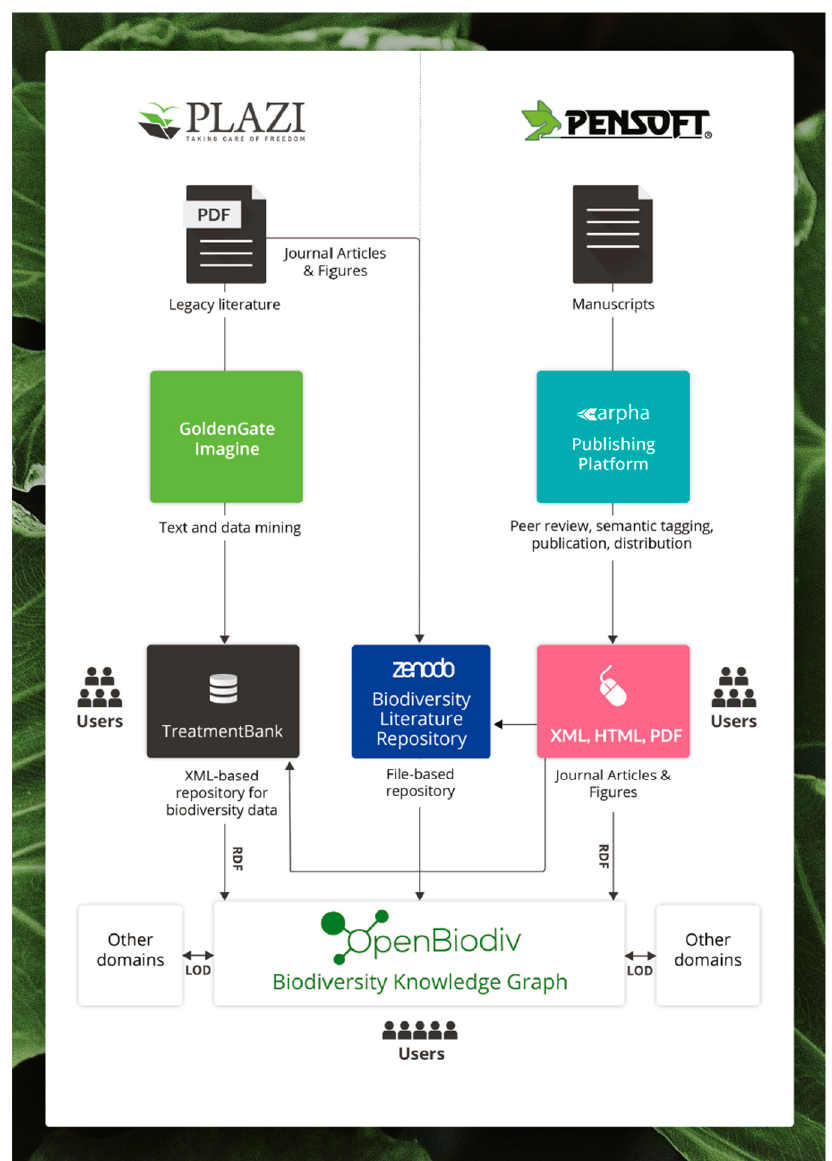
Figure 2. Data extraction and Resource Description Framework (RDF) conversion workflows from prospectively published literature (Pensoft) and legacy publications (Plazi) that feed into triples uploaded to OpenBiodiv [45].